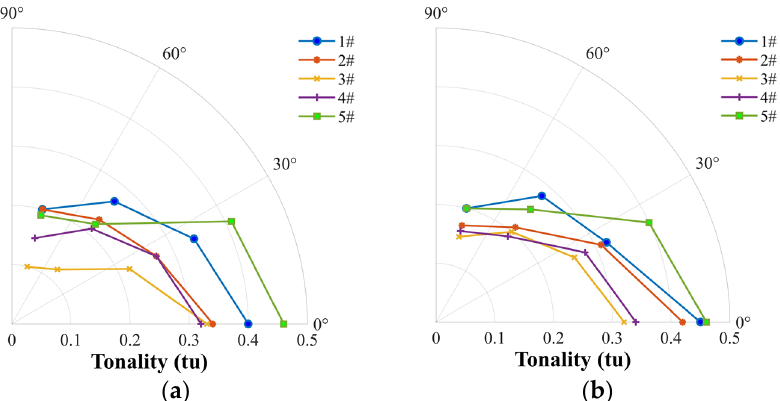
Figure 17. Comparison of tonality among the two-blade propeller (#1), four-blade propeller (#2), loop-type propeller (#3), wide chord loop-type propeller (#4), and DJI Phantom III propeller (#5) at a rotational speed of 5400 rpm ( a ) and at a stable thrust of 3 N ( b ).